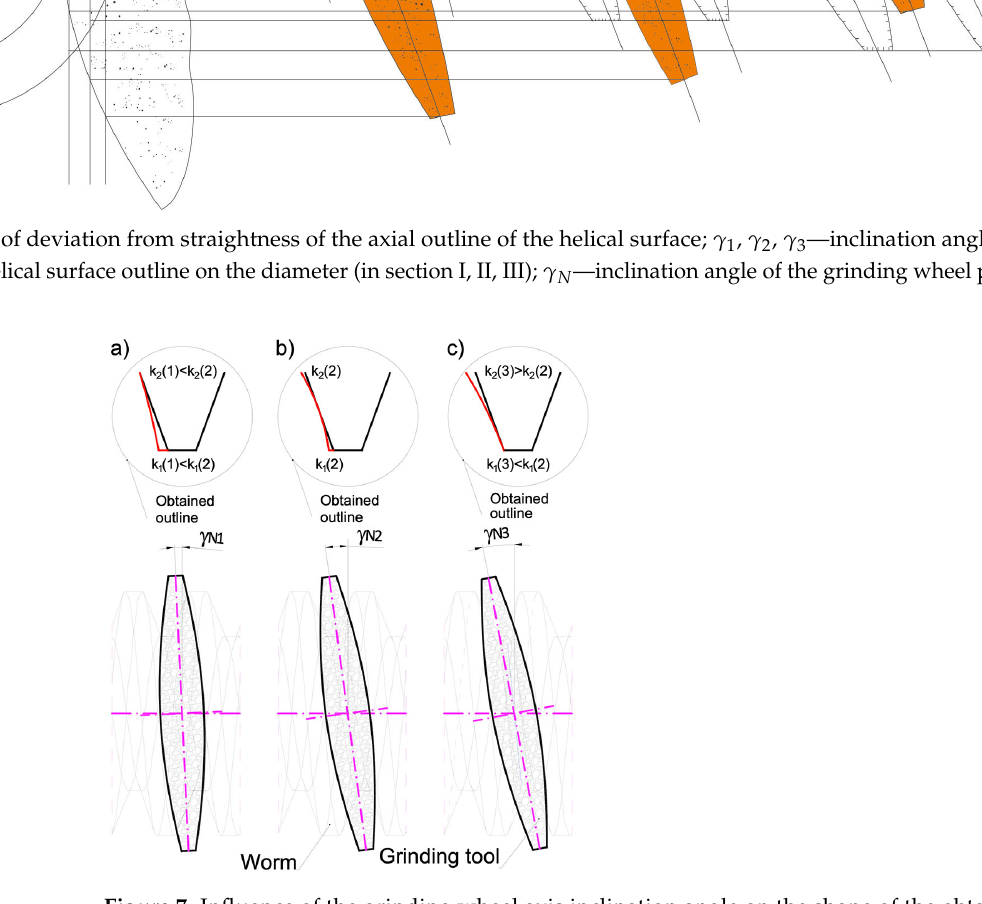
Figure 7. Influence of the grinding wheel axis inclination angle on the shape of the obtained axial outline of conical helical surface and deviations from straightness k 1 and k 2